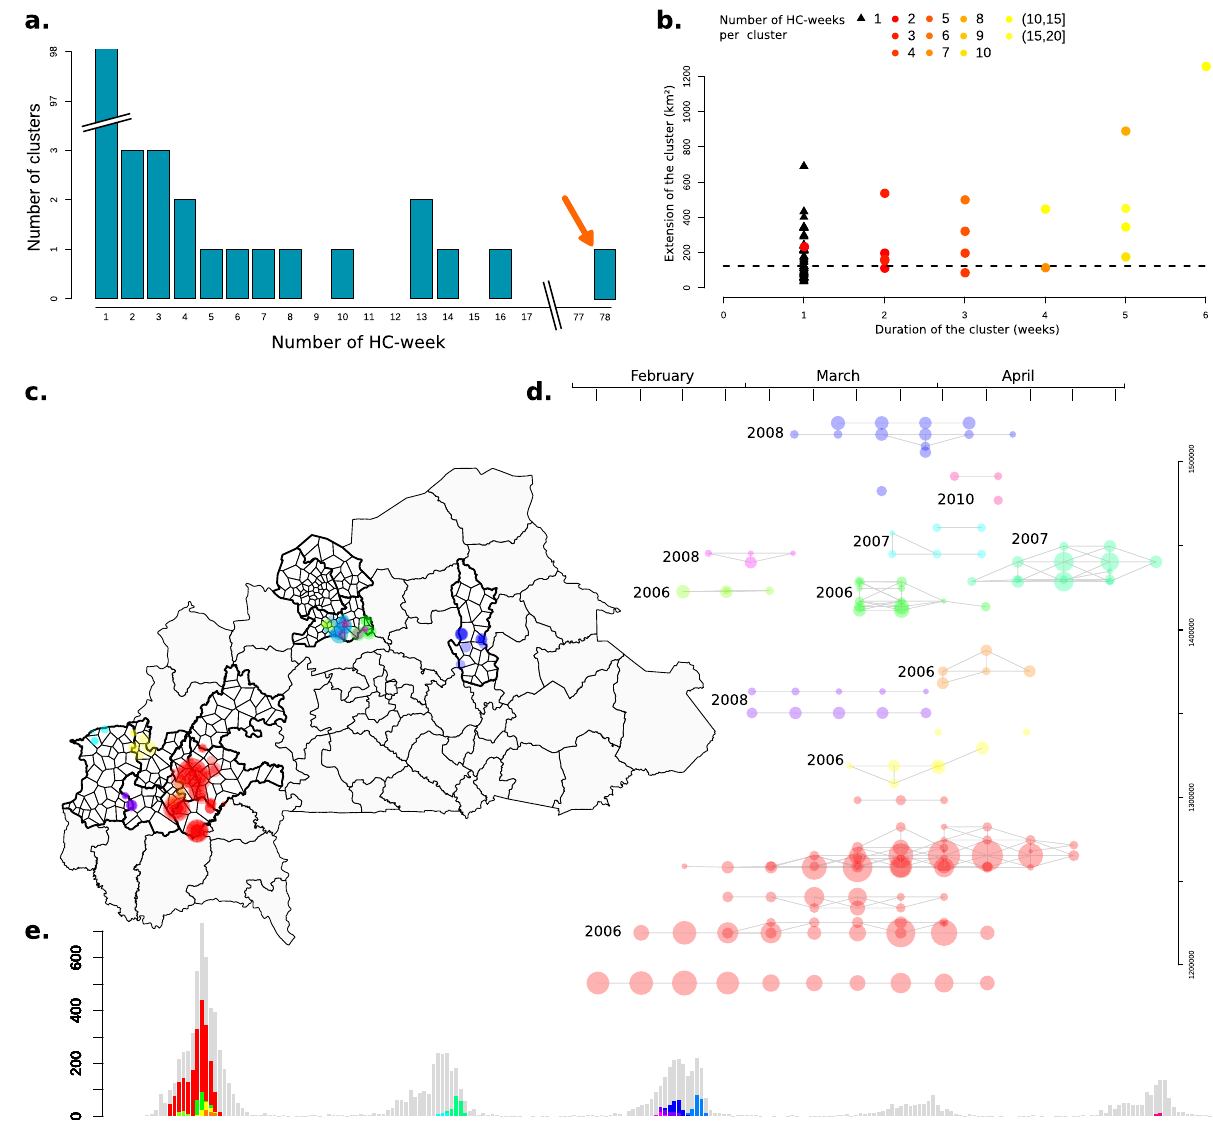
Figure 1. Temporal and spatial dynamics of localized epidemics and localized meningitis epidemic clusters (LEC) in 14 health districts, Burkina Faso, 2004–2014. ( a ) Distribution of the number of epidemic HC-week per epidemic cluster. Orange arrow: 2006 epidemic event. ( b )Temporal and spatial extension of epidemic clusters. The 2006 epidemic cluster has been omitted for visibility. ( c ) Localization of selected LCE which comprised > 1 HC week. Bold line: borders of the selected districts. ( d )Temporal and spatial dynamics among LCE comprising > 1 HC week. The clusters are vertically positioned according to geographic latitude and horizontally according to calendar week. The size of the dots represents the number of cases and connected by a line if the HC centroids are less than 14 km apart. ( e )Temporal occurrence of LCE comprising > 1 HC week. Grey bars: weekly number of cases within the study area. Coloured bars: weekly number of cases per epidemic cluster